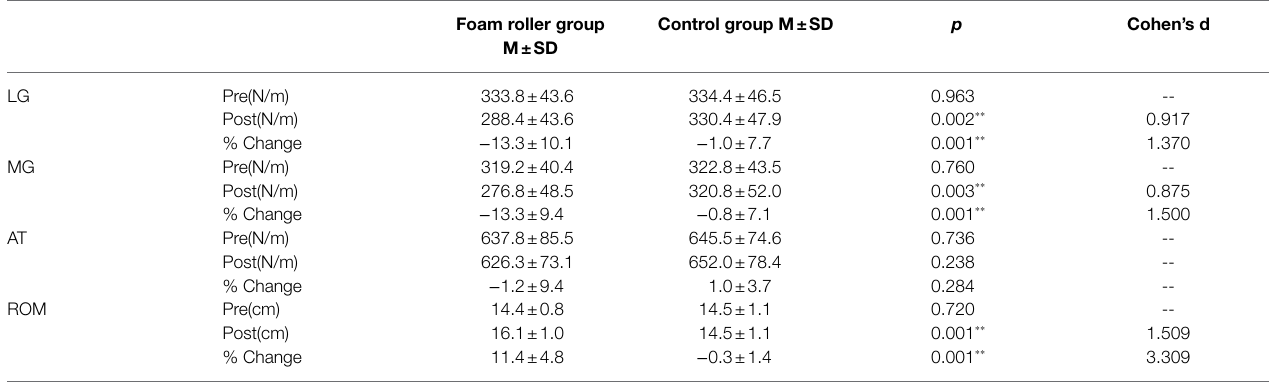
TABLE 2 | Changes in LG, MG, and AT stiffness and ankle dorsiflexion ROM before and after the intervention.